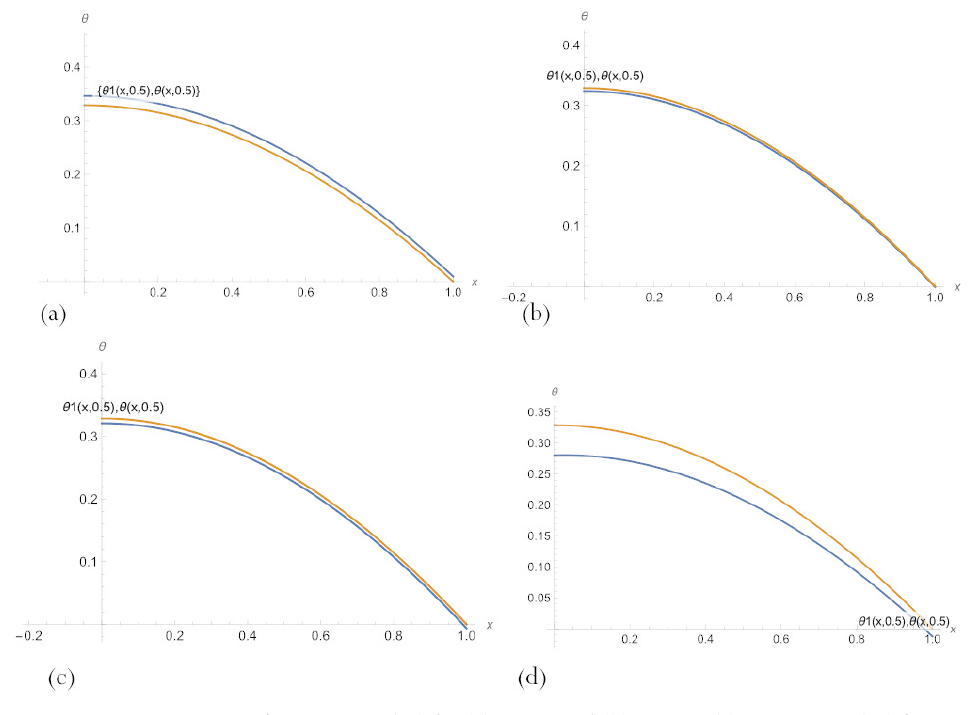
Figure 8. A comparison of PBA-PINN (20) for ( a ) n = 3 and ( b ) n = 10, ( c ) PBA-PINN (23) for n = 3, N = 1, and ( d ) classical PINN with n = 20 neurons of a hidden layer and activation function (18), after learning by minimising the loss (21), and an exact solution to the problem (11) for δ = 0.5.